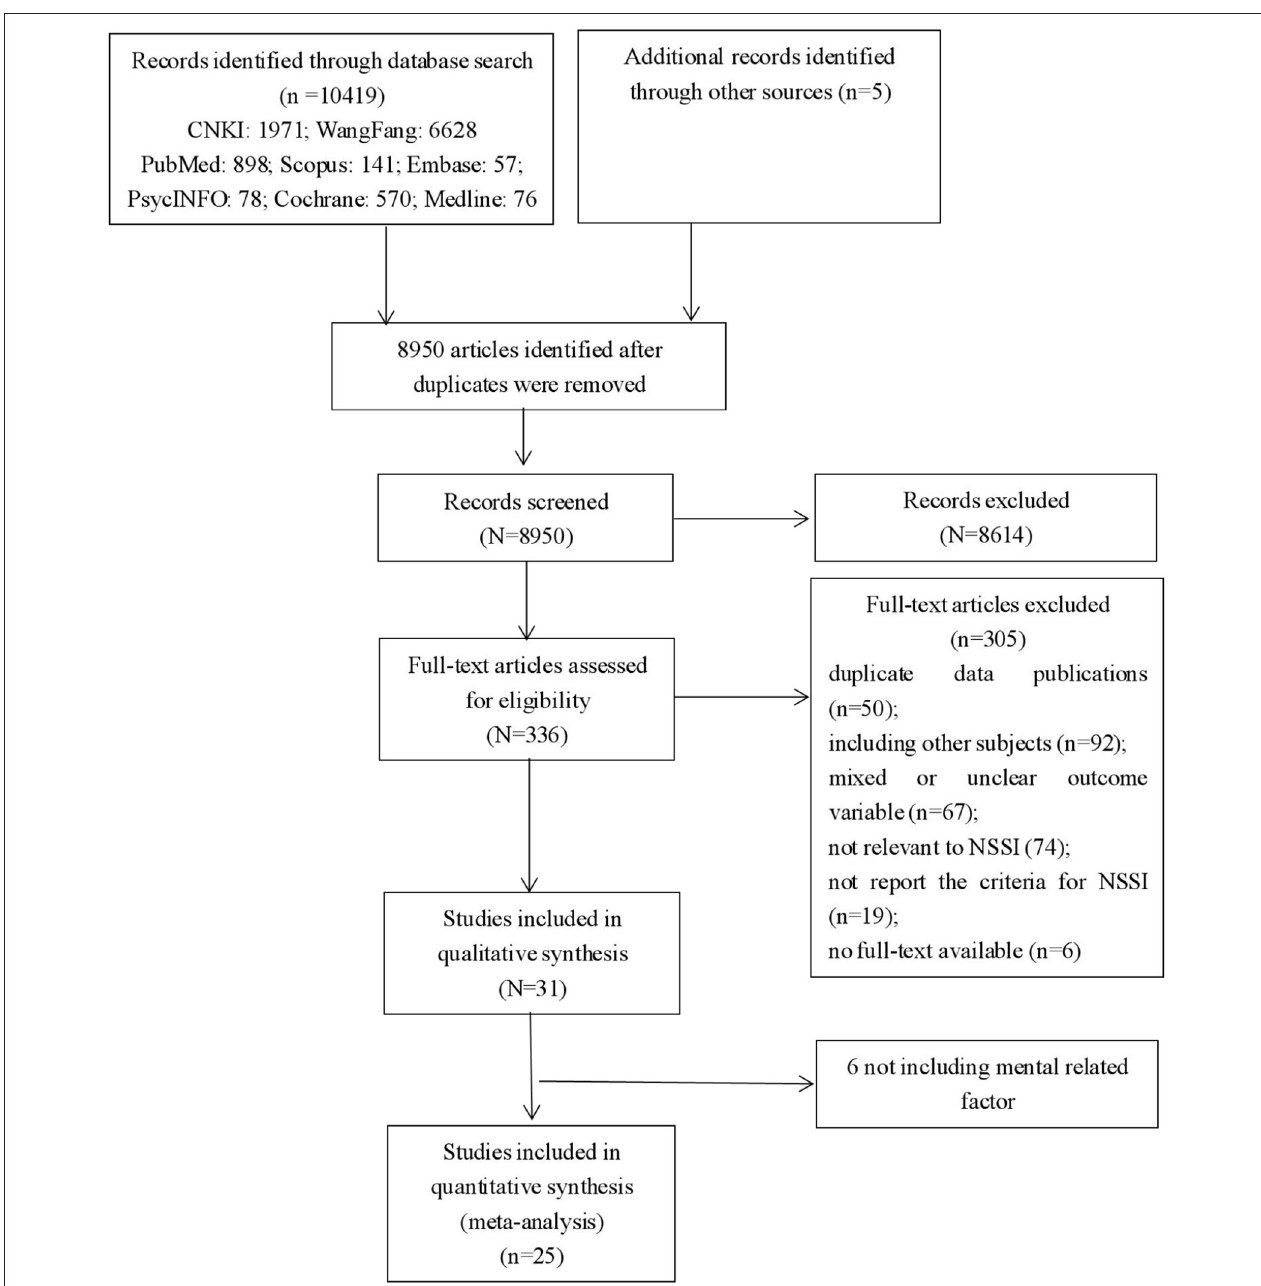
FIGURE 1 | PRISMA flow chart for meta-analysis of publication on non-suicidal self-injury in